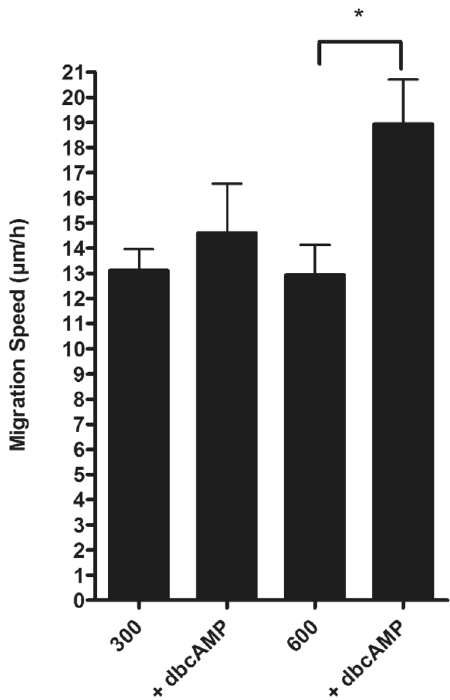
Figure 9. The treatment with dbcAMP induced the migration speed of the cells. Wound healing assays were performed with IMCD-cells cultivated at 300 or 600 mosmol/kg. A wound was induced migration of the cells were observed for 15 h. During this period of time one part of the cells were treated with dbcAMP (250 µM). The migration speed of the cells were calculated and significantly differences were calculated by ANOVA (p < 0.05, n ≤